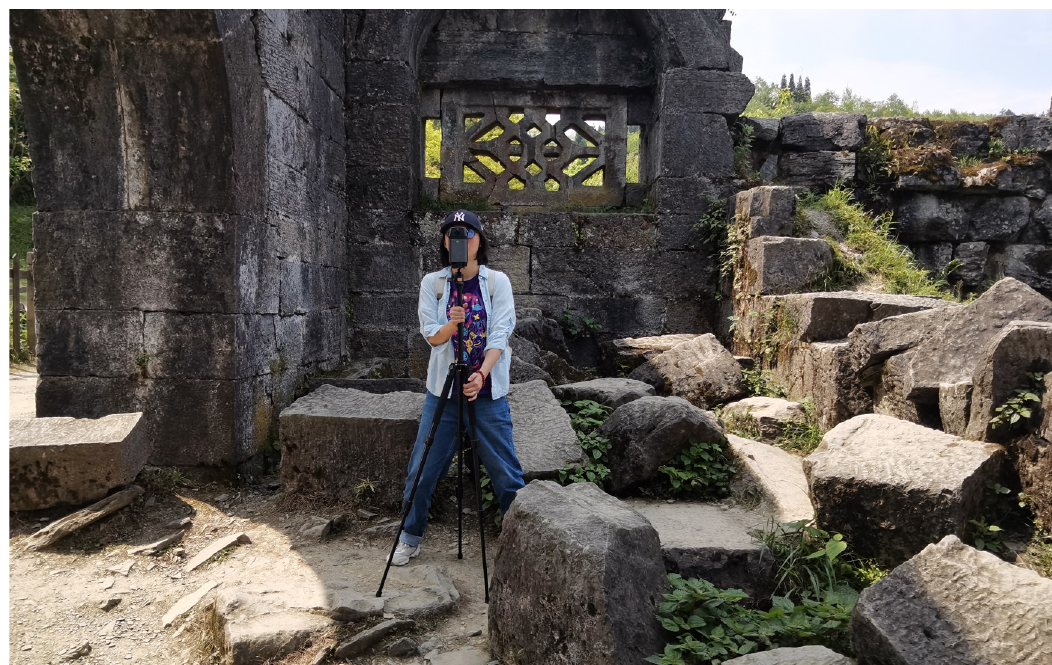
Figure 2: Panoramic shooting at the heritage site.